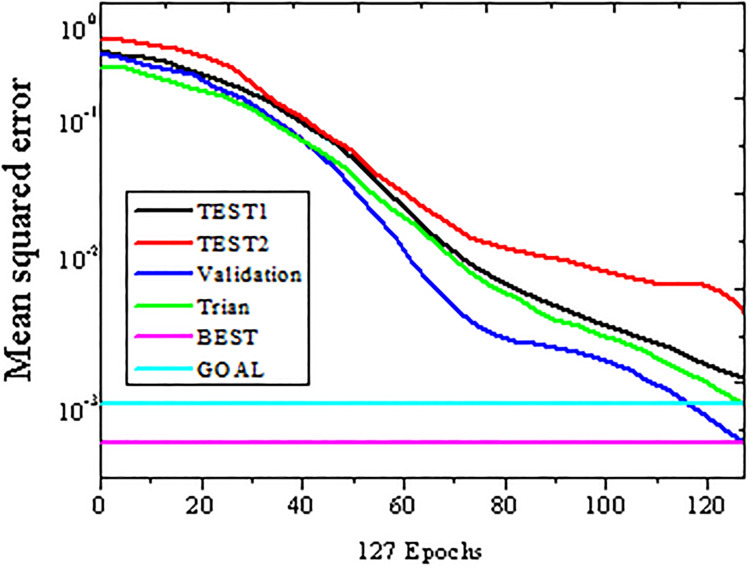
BPNN simulation results.